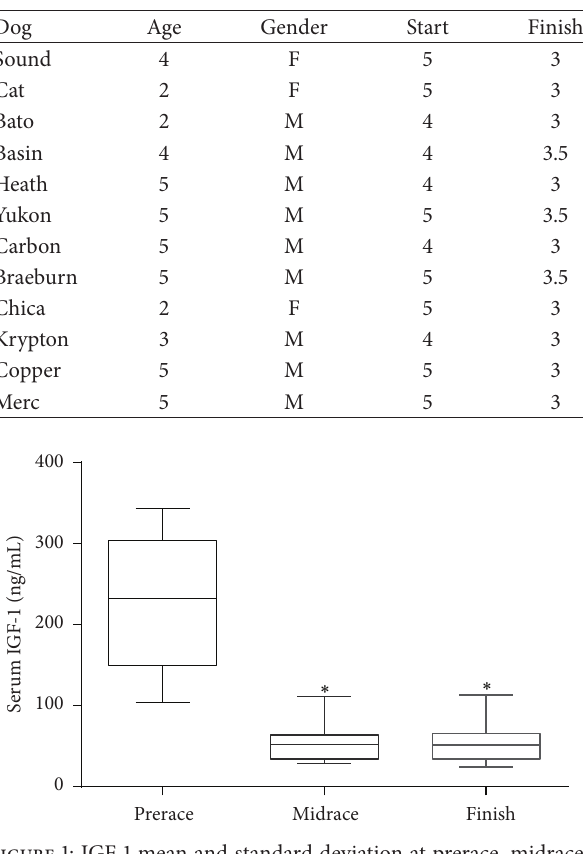
Figure 3: IGFBP-3 at prerace, midrace, and race finish. Boxes represent median and 75th and 25th percentiles and whiskers represent 1st and 99th percentiles. ∗ indicates a significant difference from the prerace values ( 𝑃 < 0.01